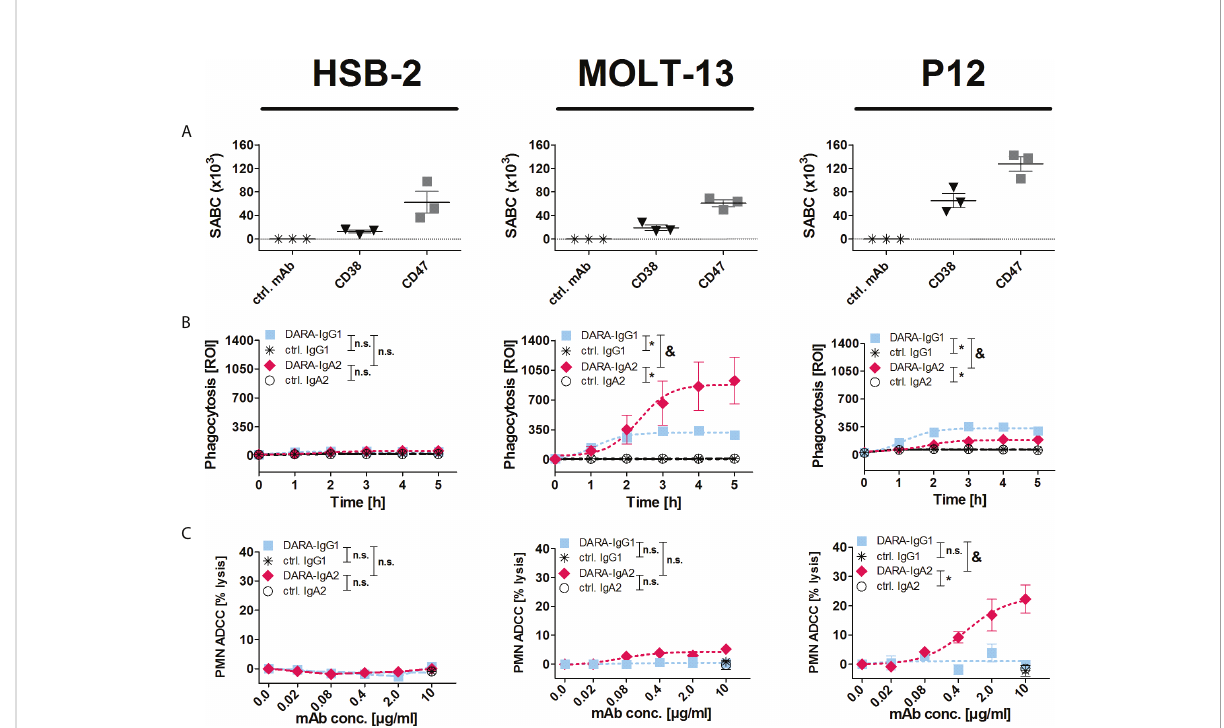
FIGURE 1 DARA-IgA2 mediates T-ALL cell killing by myeloid cells. (A) Expression of CD38 and CD47 on T-ALL cell lines HSB-2, MOLT-13 and P12- ICHIKAWA (P12) was quanti fi ed by indirect fl ow cytometry to determine the speci fi c antigen-binding sites per cell (SABC). Mouse monoclonal antibodies against CD38 (clone HB-7) and CD47 (clone B6H12) were used at saturating concentrations (5 µg/ml) and detected with FITC- conjugated anti-mouse IgG F(ab ’ ) 2 fragments. The results from 3 independent experiments with means ± SEM are shown. The values of the control samples (ctrl. mAb) were subtracted from the values obtained with the antibodies. (B) Macrophage-mediated ADCP (E:T = 1:1) was analyzed by real-time fl uorescence imaging over 5 h (300 min). Target cells were labelled with a pH-dependent red fl uorescent dye (pHrodo), and phagocytosis was measured as red object counts per image (ROI) every 60 min. Antibodies were used at 10 µg/ml. Results are presented as means ± SEM of at least 3 experiments with effector cells from different donors. * indicates signi fi cant differences between DARA-IgG1 and IgG1 isotype control (ctrl. IgG1) or DARA-IgA2 and IgA2 isotype control (ctrl. IgA2) (p < 0.05 by two-way ANOVA), and & marks signi fi cant differences between DARA-IgG1 and DARA-IgA2 (p < 0.05 by two-way ANOVA). n. s., not signi fi cant. (C) PMN mediated ADCC (E:T = 80:1) was analyzed in 3 h 51 Cr release assays with the indicated antibody concentrations (0-10 µg/ml) using GM-CSF (50 U/ml) stimulated PMN. Results are presented as means ± SEM of at least 3 experiments with effector cells from different donors. * indicates signi fi cant differences between DARA and isotype control (ctrl.) antibodies at the highest concentration (10 µg/ml) (p < 0.05 by one-way ANOVA), & marks signi fi cant differences between IgG1 and IgA2 (p < 0.05 by two-way ANOVA). n. s., not signi fi